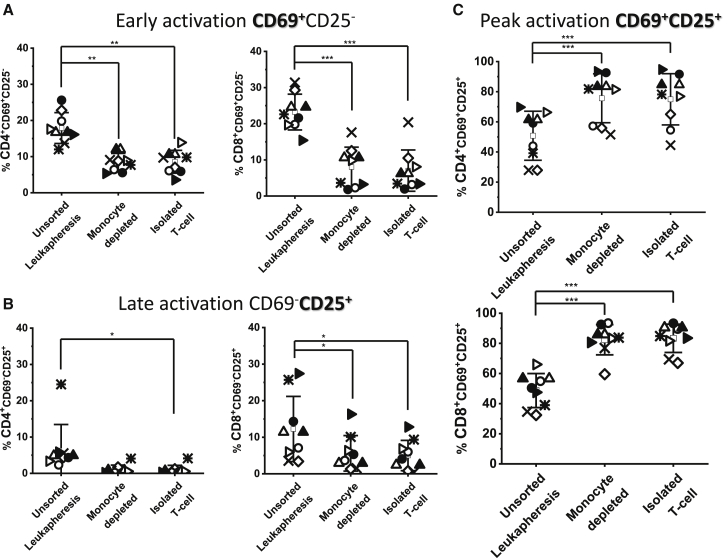
Review of activation marker CD69 and CD25 expression by CD4+ and CD8+ T cell populations after CD3/CD28 bead-based activation in a 100-mL culture bag(A) Early activation (CD69+CD25−), (B) late activation (CD69−CD25+), and (C) peak activation (CD69+CD25+) by CD4+ and CD8+ T cells after 48-h Dynabead activation of unsorted leukapheresis, monocyte-depleted, and isolated T cell starting populations. 5 different donors were activated: donor 1 (◇), donor 2 (○), donor 3 (⨯), donor 4 (▵), and donor 5 (▹). Donors 2, 4, and 5 were replicated for subsequent CAR viral transduction alongside donor 9 (denoted donor 2_CAR [●], donor 4_CAR ▴], donor 5_CAR [▸], and donor 9_CAR [★]). Error bars represent the mean ± 1 SD, where the mean of the value is represented by □. Statistical significance was determined by one-way ANOVA and Dunnett’s hypothesis testing; ∗p < 0.05, ∗∗p < 0.01, and ∗∗∗p < 0.001.